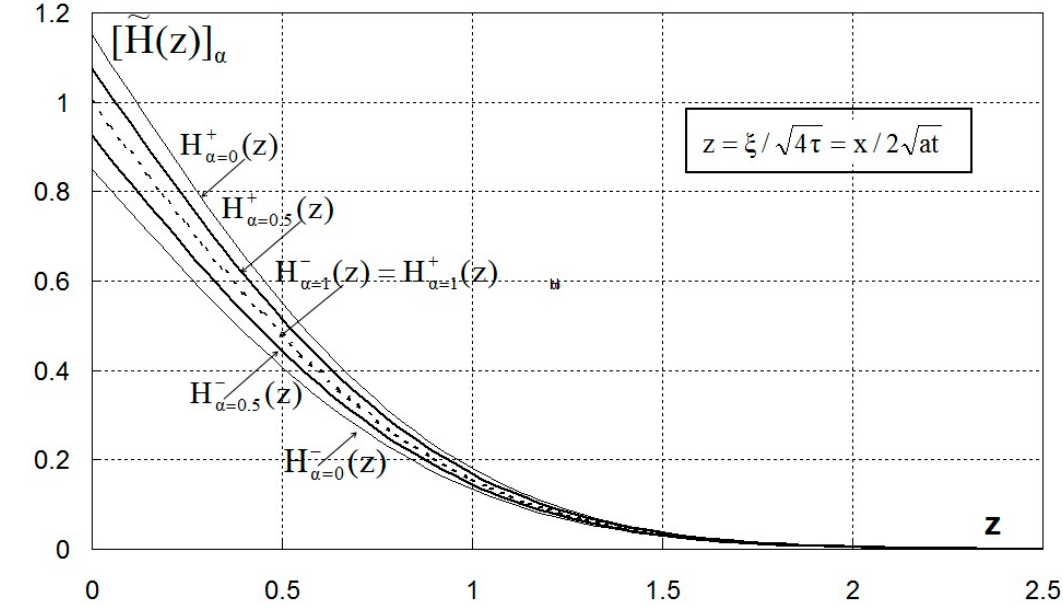
Figure 7. Dimensionless depth as a function of z for α = 0, 0.5, and 1.